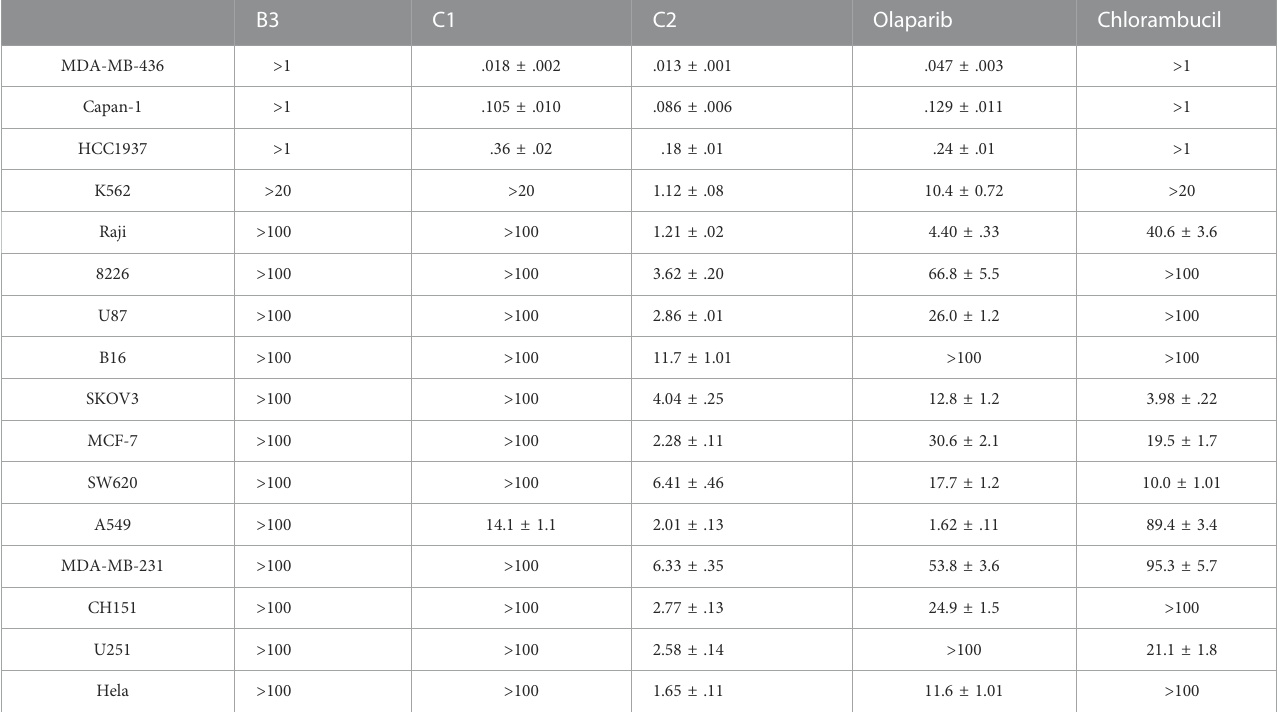
TABLE 3 In vitro antiproliferative activities of representative compounds (IC 50 , μ M a ).